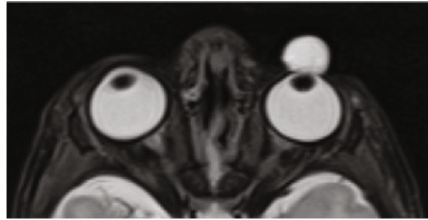
Figure 2: T2-weighted MRI of the orbits, axial view. Unilocular cyst arising from the anterior portion of the left globe.